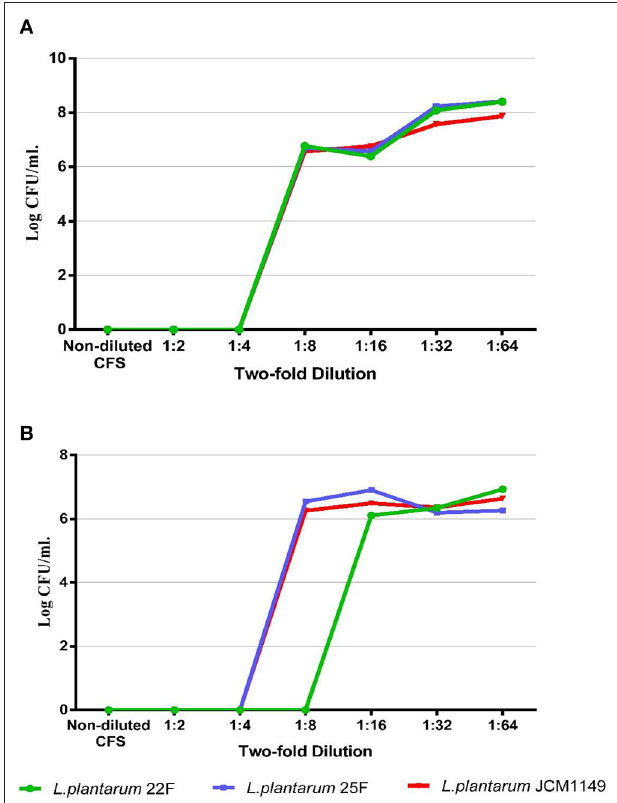
FIGURE 1 | Bacterial survival of representative donor strain (A) and recipient strain (B) after culture with non-diluted and diluted CFS (non-diluted to 1:64) produced from selected LAB.